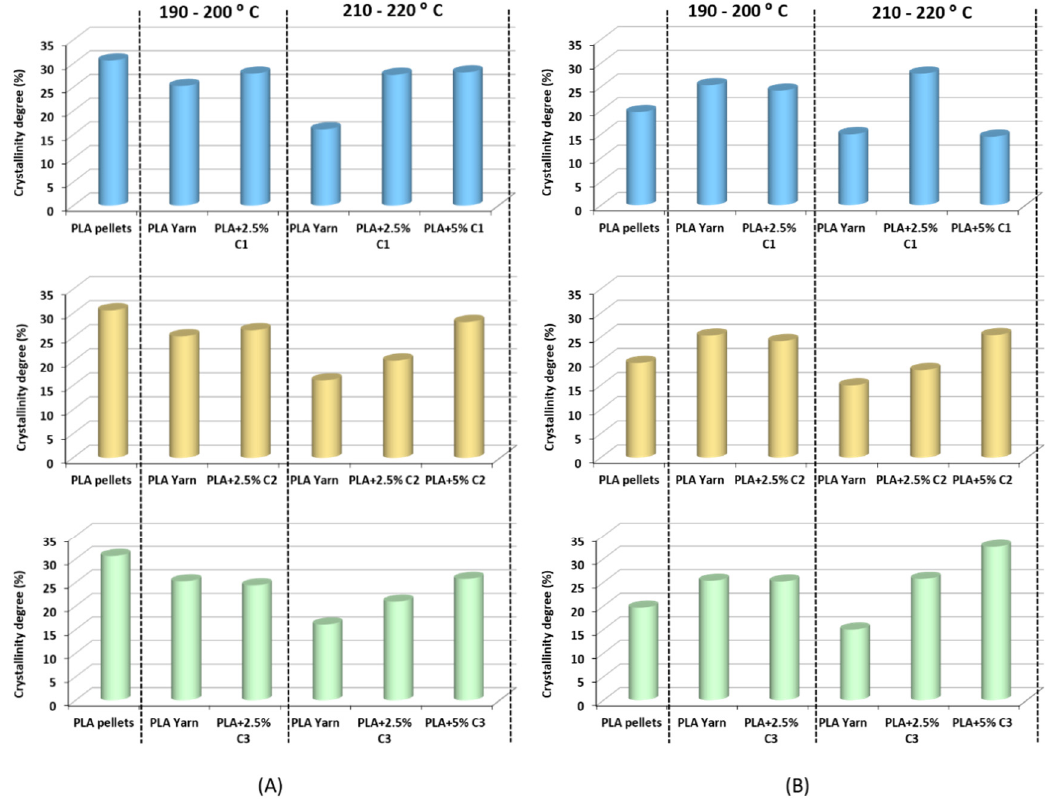
Figure 4. Influence of processing temperatures and types of compatibilizers on the crystallinity degree of the PLA-based samples from the ( A ) first heating cycle and ( B ) second heating